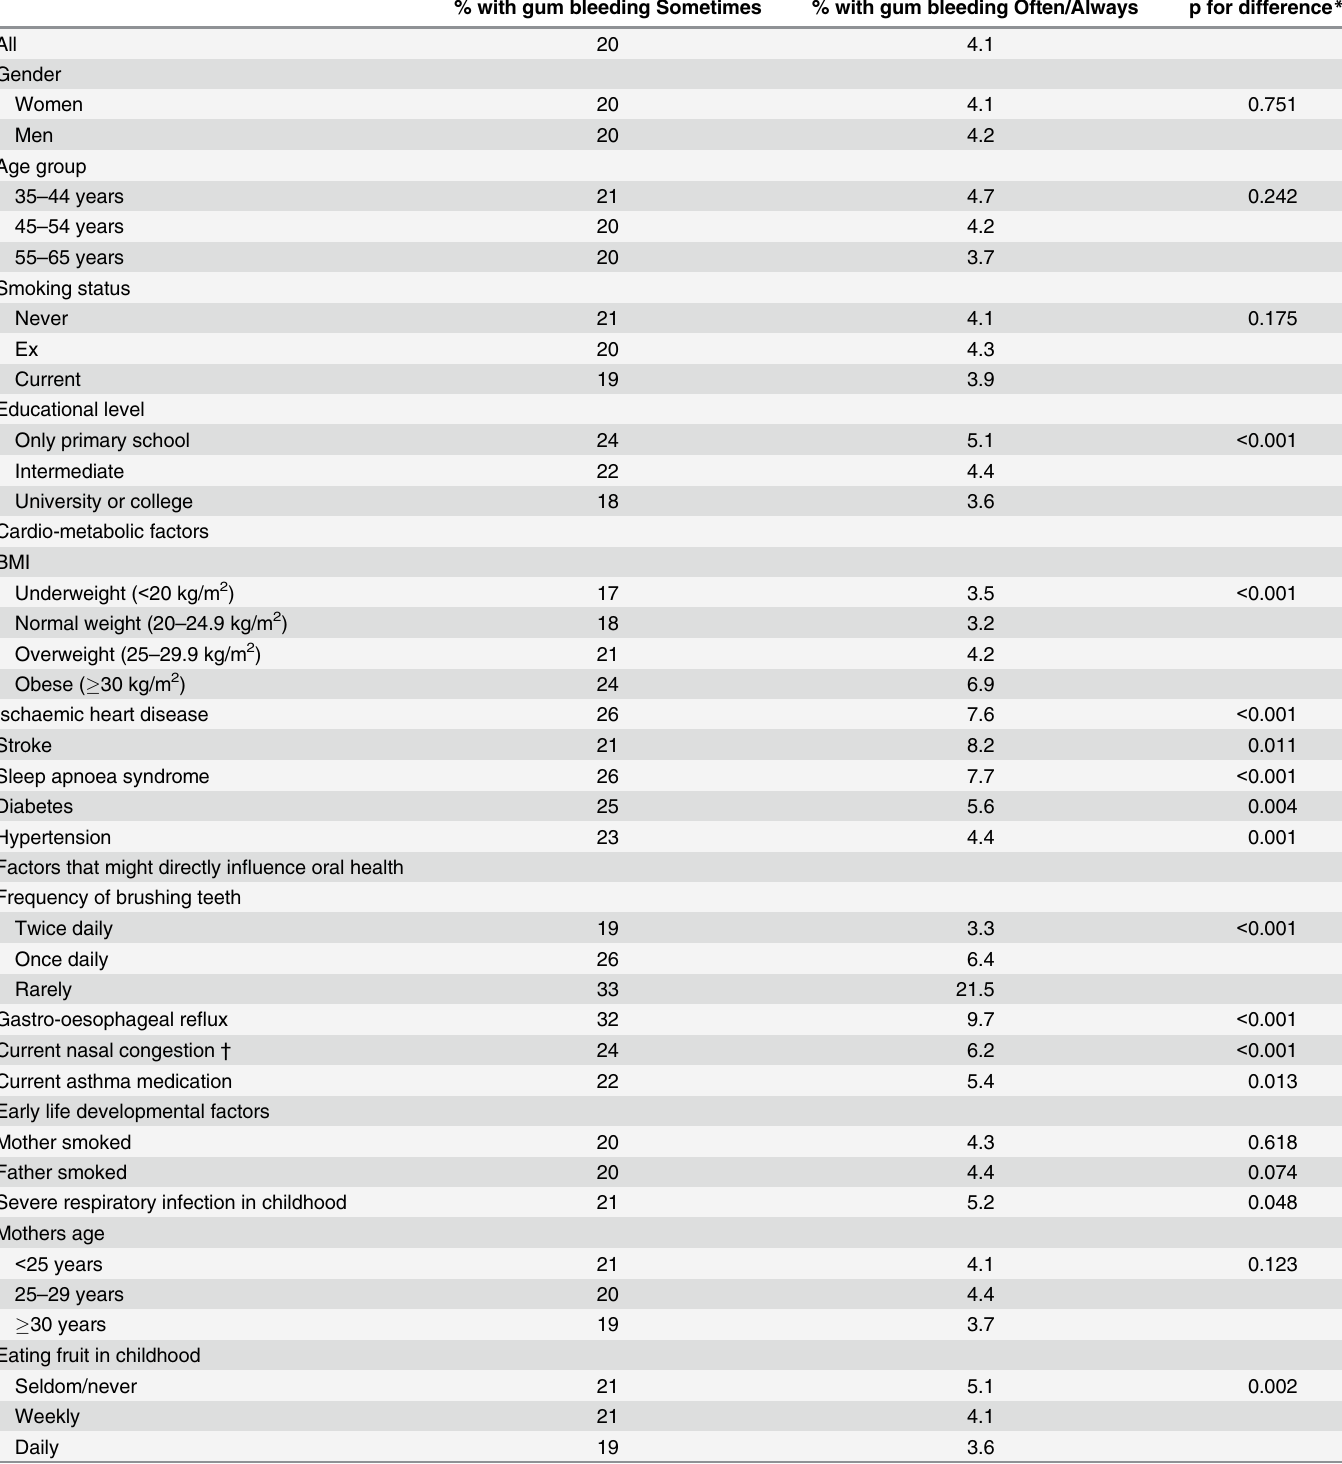
Table 2. Prevalence of gum bleeding according to population characteristics in 13,409 RHINE III participants. % with gum bleeding